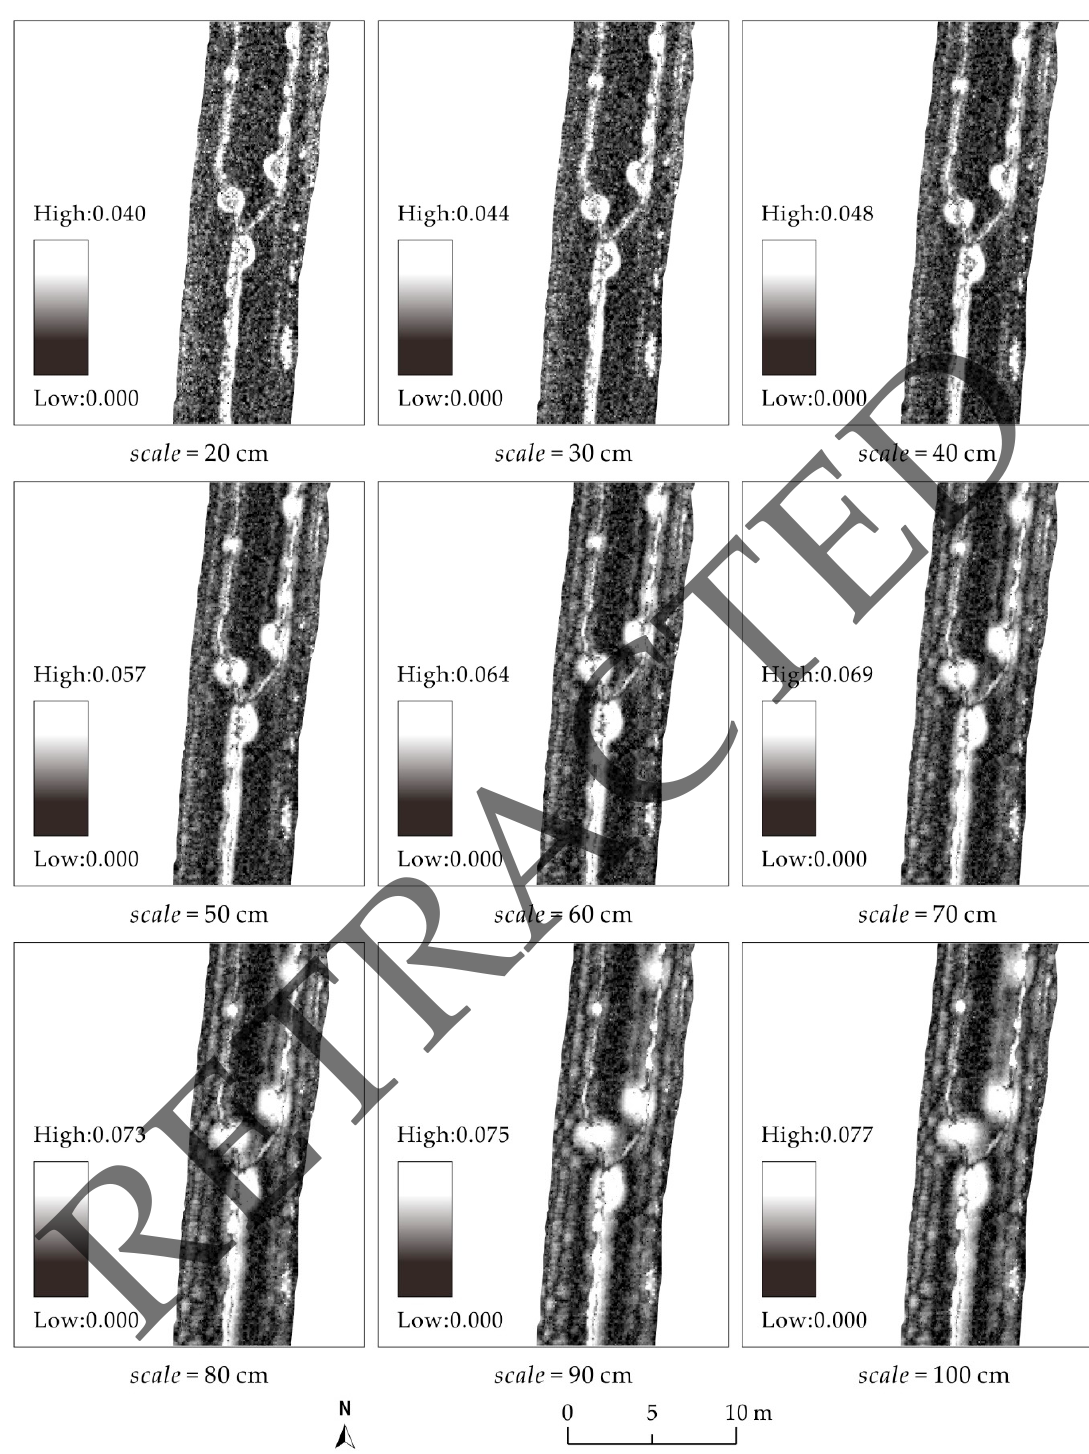
Figure 8. Distribution of the roughness index on microscopic scales.